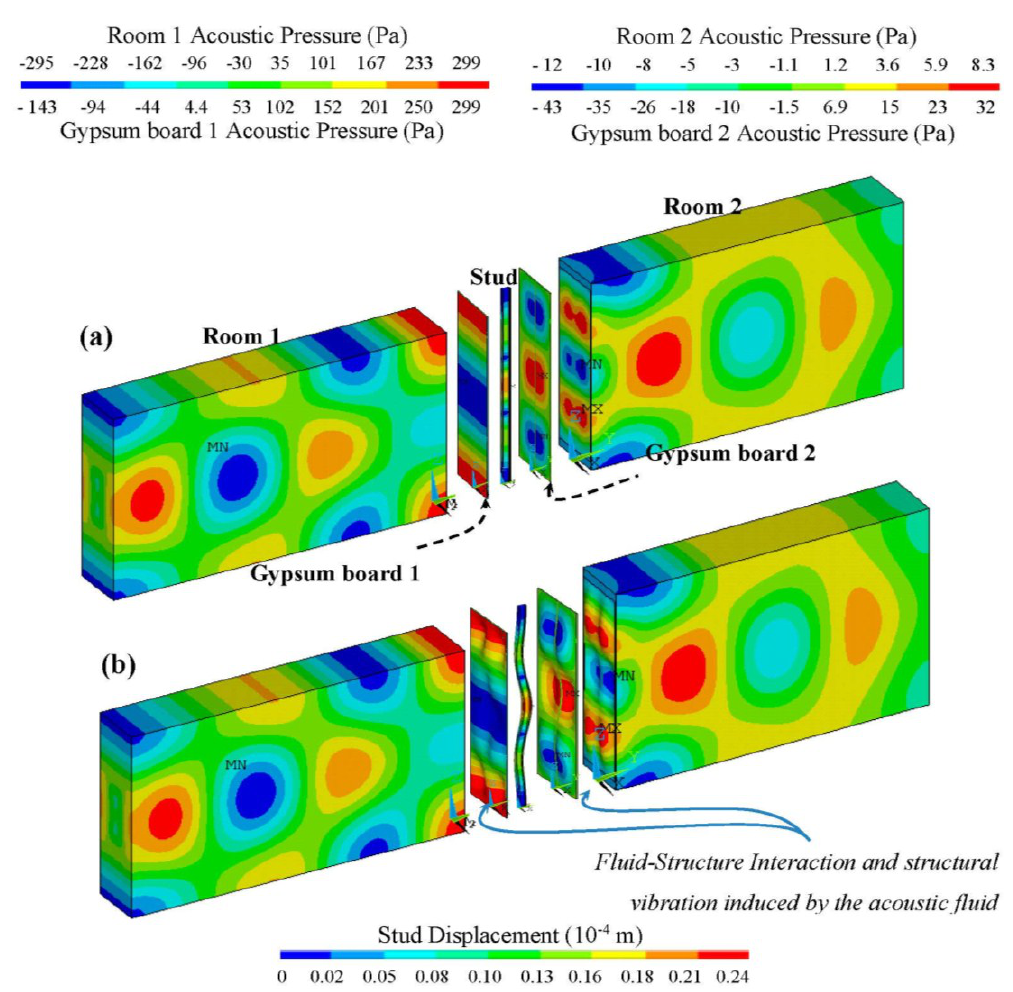
Figure 6. Pressure distribution for a frequency of 160 Hz, showing FSI, ( a ) true scale view and ( b ) scaled displacement view with a magnification factor of 2000 showing acoustically-induced structural